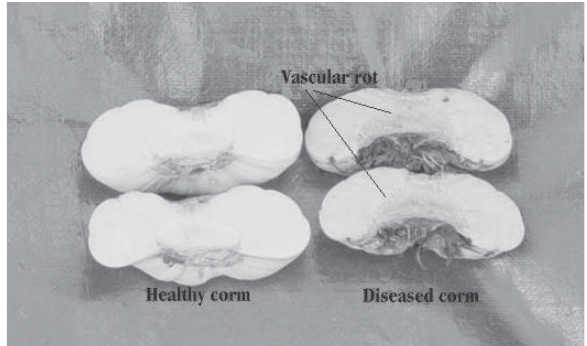
Fig. 1. Longitudinal section of healthy corm of gladiolus cv. Her Majesty, and corm infected with Fusarium ox- ysporum f. sp. gladioli and showing vascular rot.